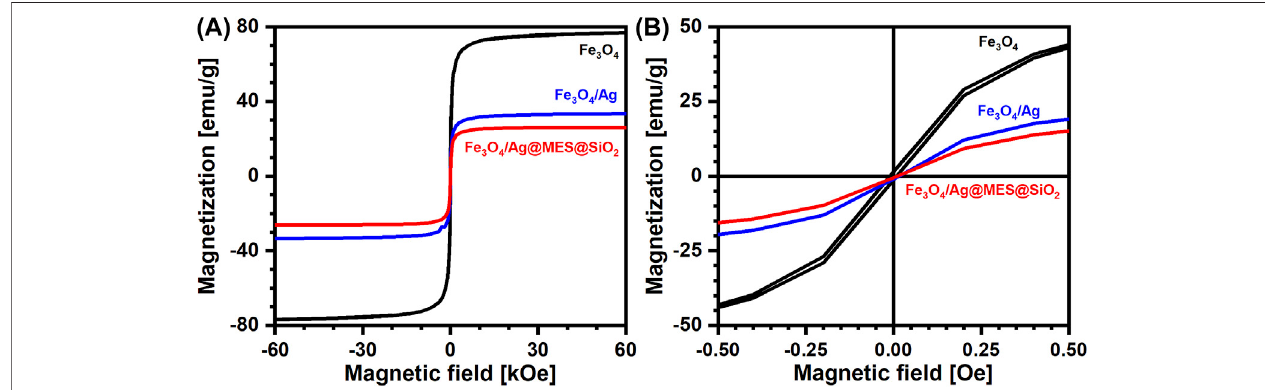
FIGURE 4 | (A) Magnetization curves measured by SQUID magnetometry at 300.0 K for the products synthesized at a given preparation step (see legend). (B) Enlarged region of the graph shown in (A) presenting the zero coercivity under studied conditions.